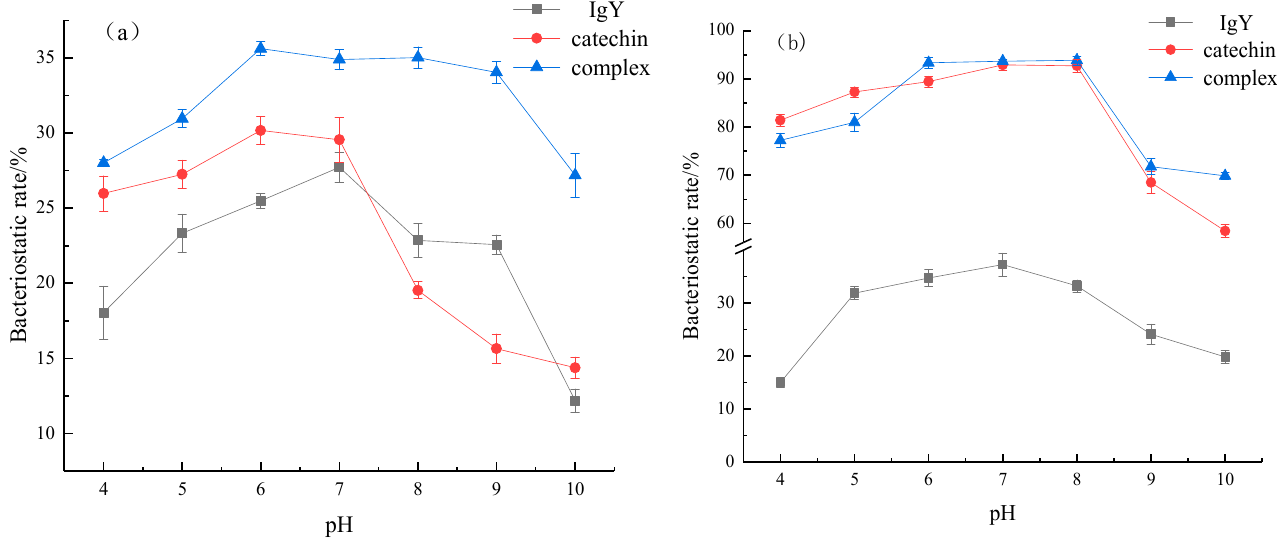
Figure 6. Effect of IgY interacts with catechins on antibacterial acid–base stability of E. coli ( a ) and S. aureus ( b ).